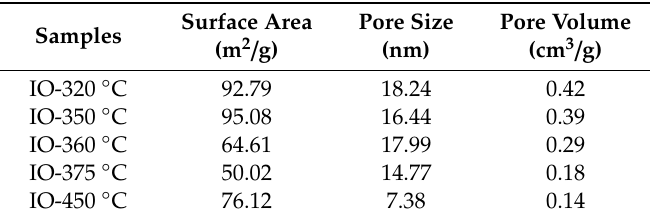
Figure 4. The nitrogen adsorption-desorption isotherms and pore diameter distribution plot (inset) of the iron carbide catalysts at di ff erent carburization temperatures. Table 1. The textural properties and crystallite size of iron carbide catalysts treated at di ff erent carburization